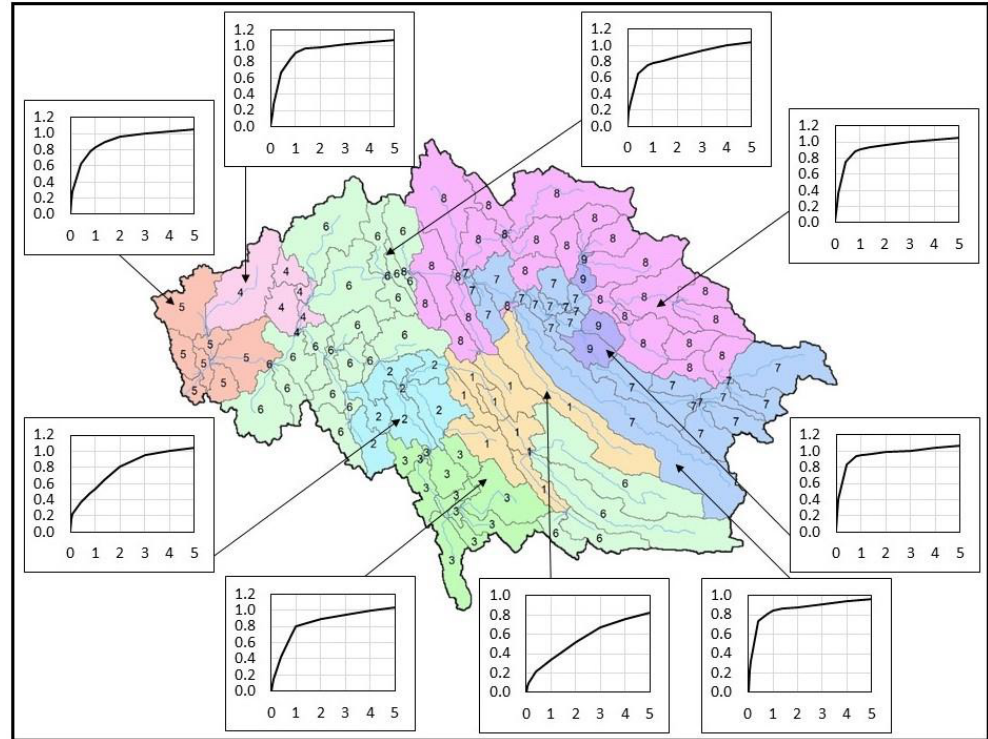
Figure 12. Regional Storage-Yield Curves of Kalu Ganga with minor sub-basins having similar curves indicated by color and number. Graphs show storage capacity on the horizontal axis; WS Yield on the vertical axis in MAR units.